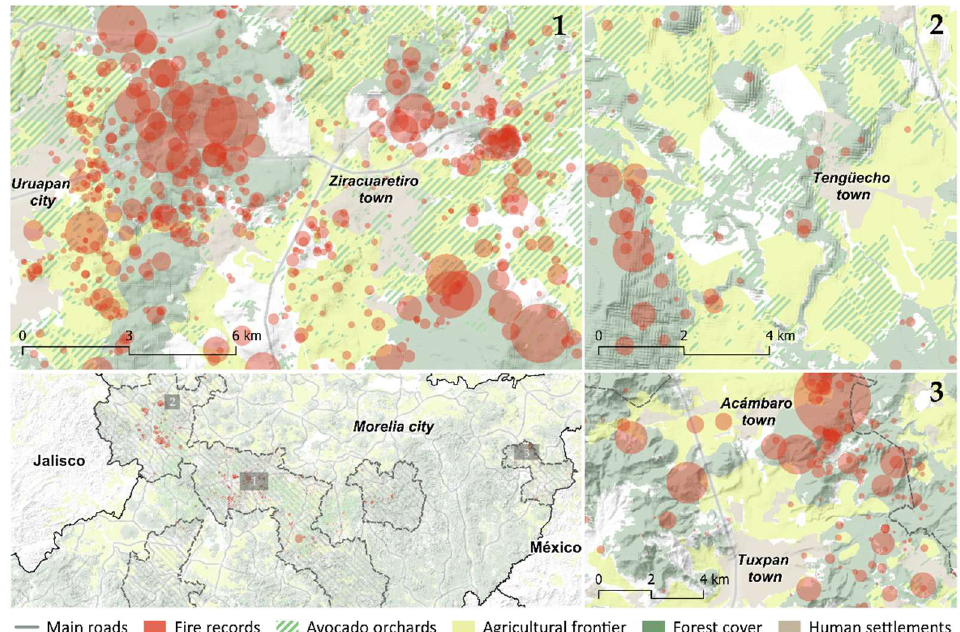
Figure 5. Eighteen years of fires across the Michoacan Avocado Belt: ( 1 ) high fire activity and recurrence associated with orchards and main roads; ( 2 ) isolated fires in remanent forests enclosed by the agricultural frontier; ( 3 ) fire records in one of the monarch butterflies’ arrival areas.